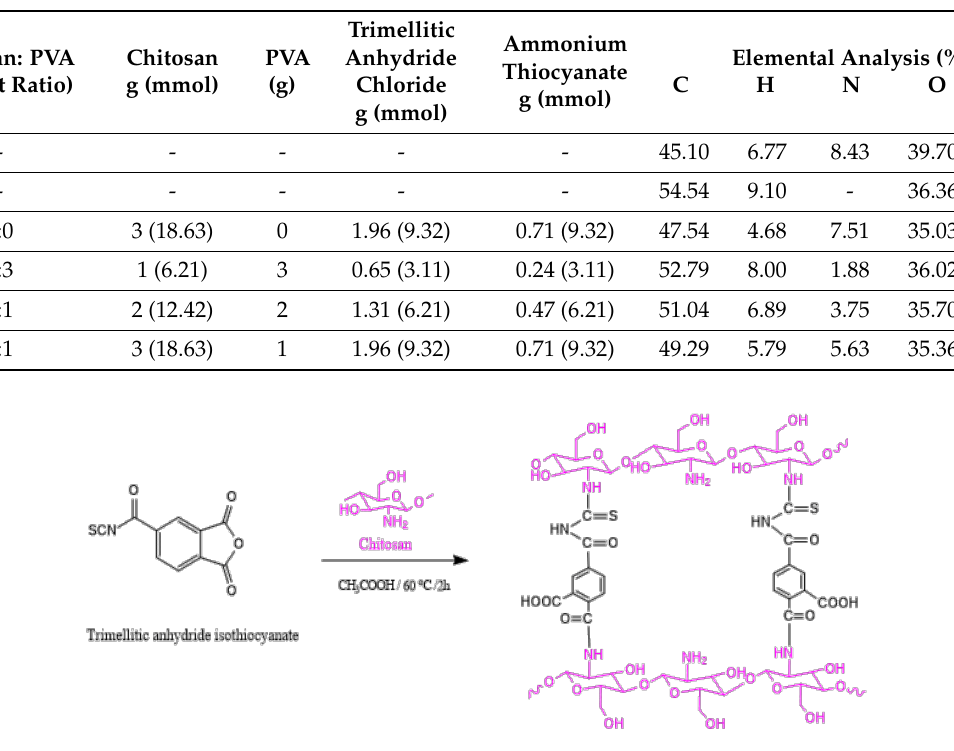
Table 1. Synthesis and elemental analyses of chitosan/PVA hydrogels.